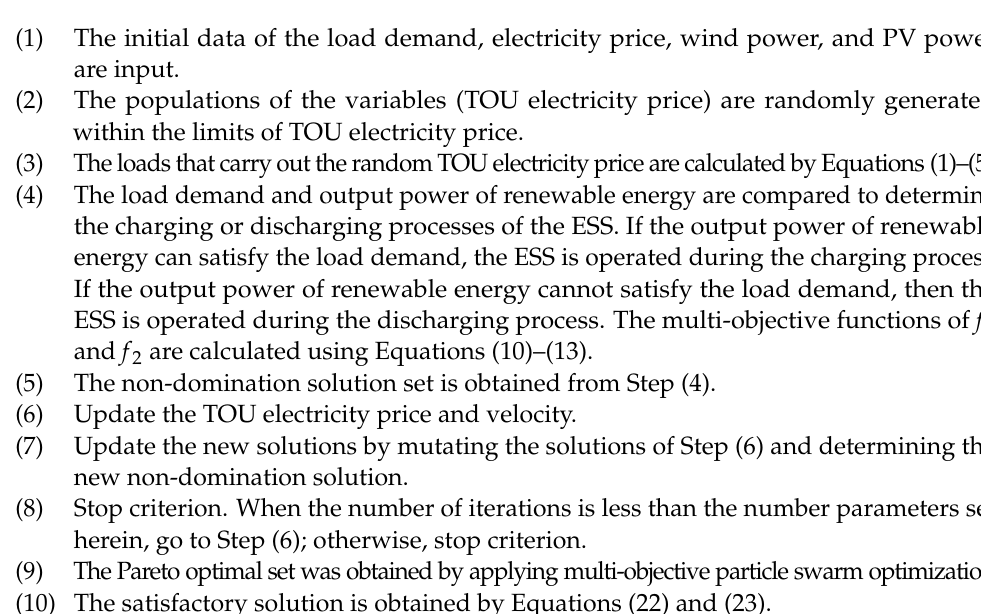
Figure 2. Flowchart of the optimization